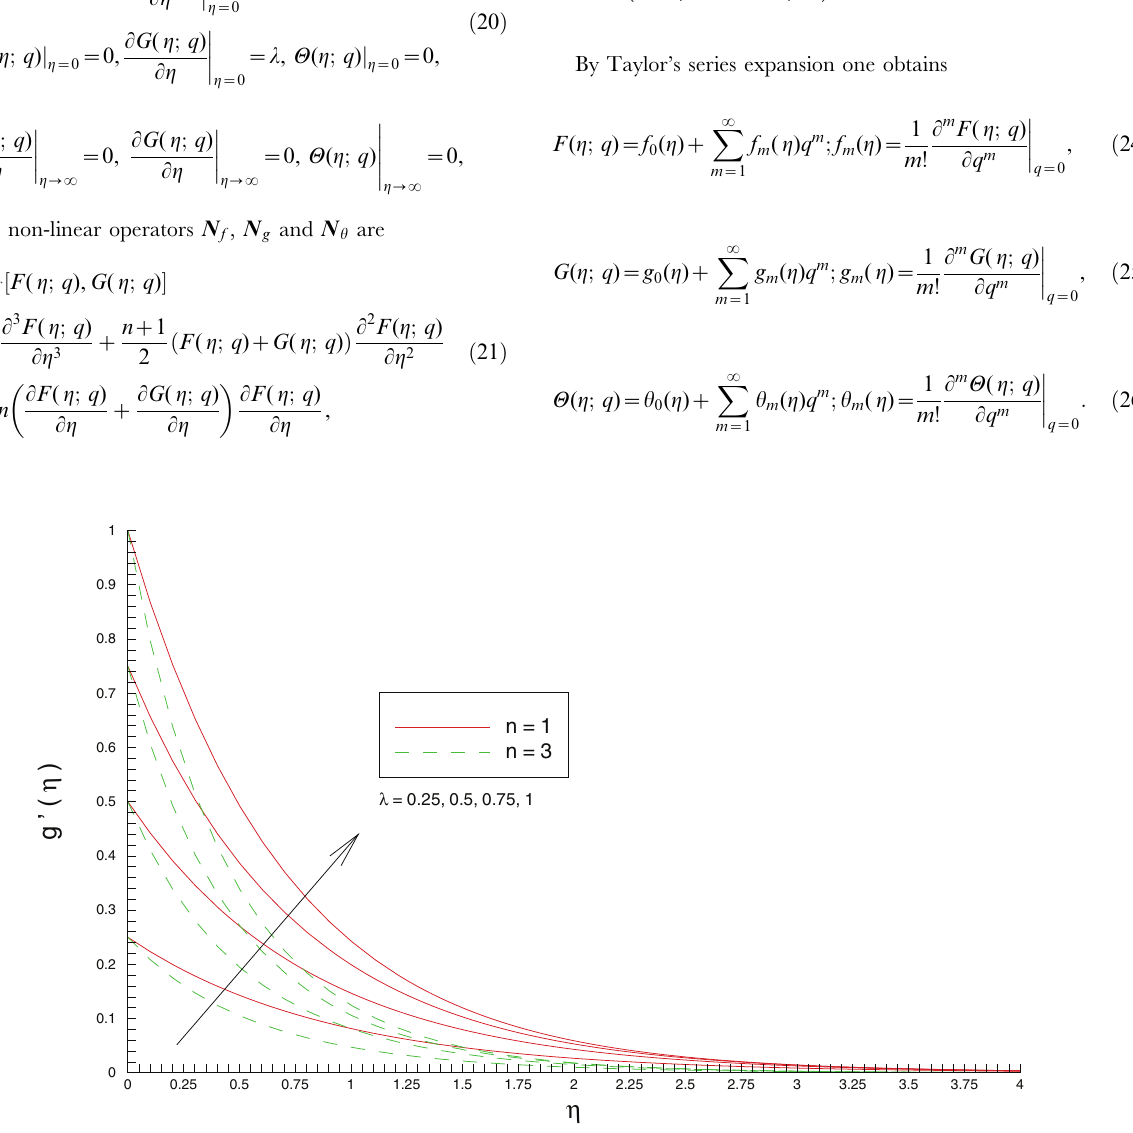
Figure 4. Influence of stretching rates ratio l on the y { component of velocity g 0 :